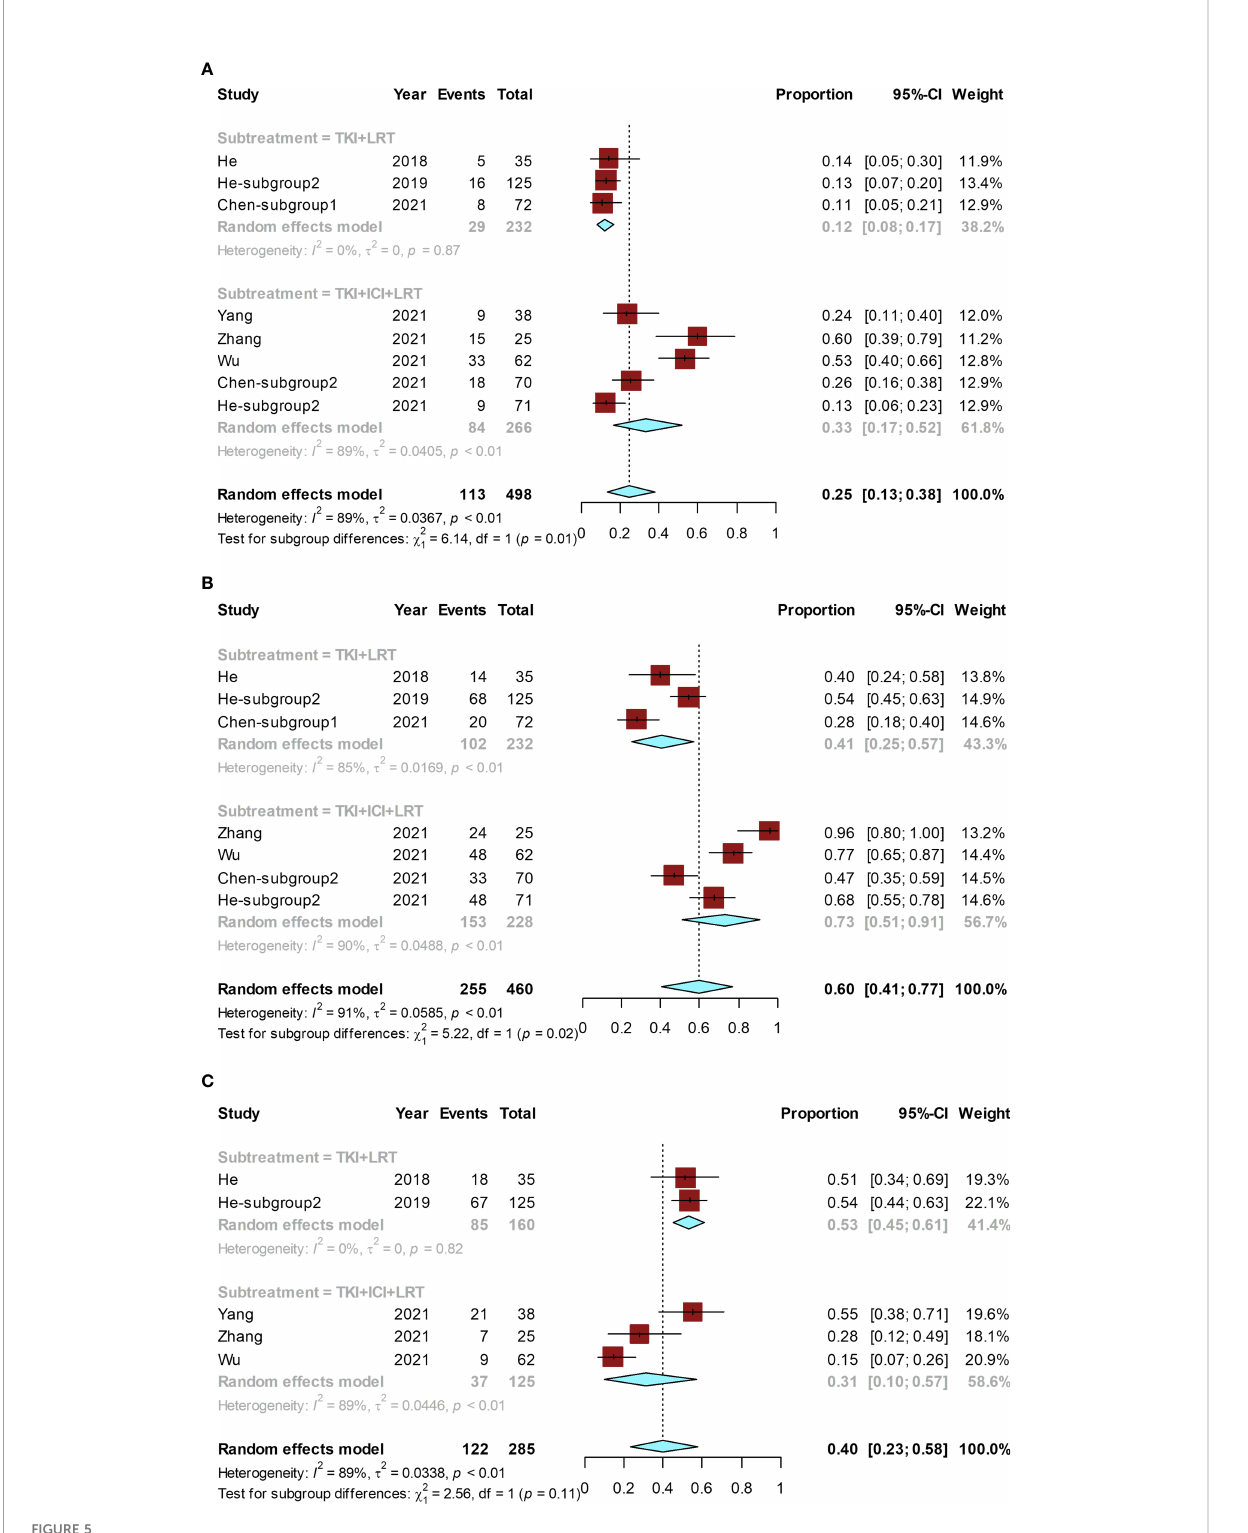
FIGURE 5 Forest plot for the combined locoregional-systemic therapy group. The pooled conversion rate and subgroup analysis (A) , pooled ORR and its subgroup analysis (B) , and the pooled rate of grade ≥ 3 AEs and its subgroup (C) . These subgroup analyses were conducted according to combination of treatments. LRT, locoregional